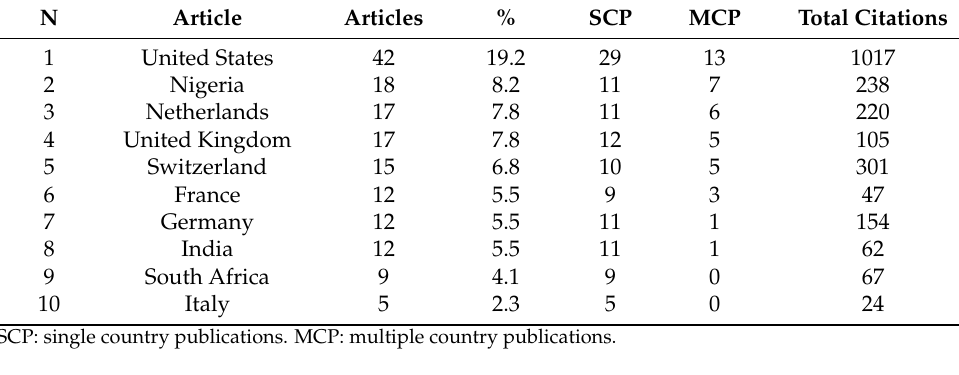
Table 3. Top 10 countries of authors with publications on noma.